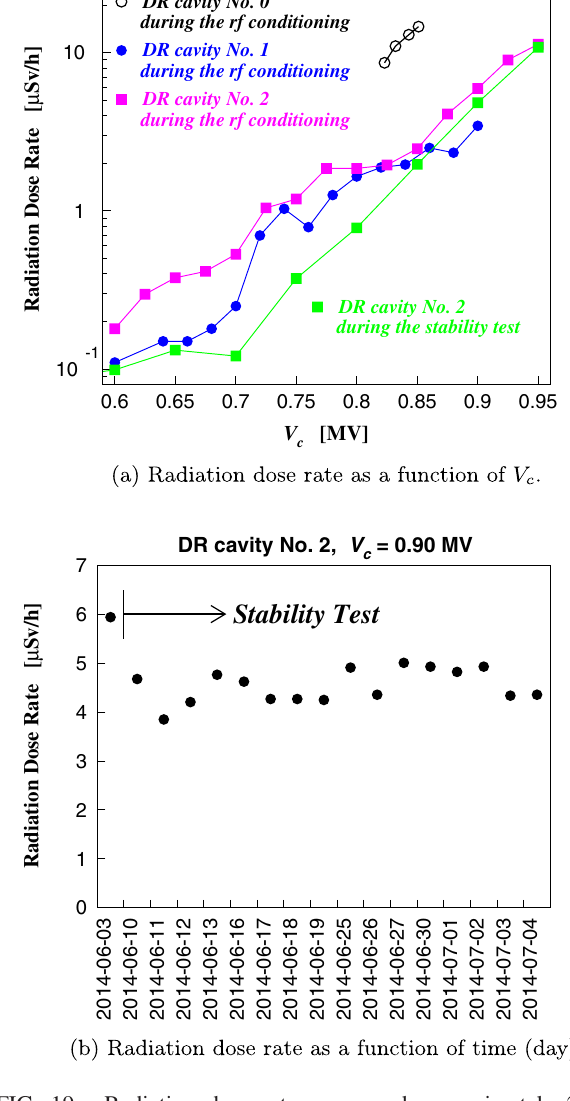
FIG. 19. Radiation dose rates measured approximately 2 m from the cavities in the radiation-controlled area. The background level was approximately 0 . 1 μ Sv =